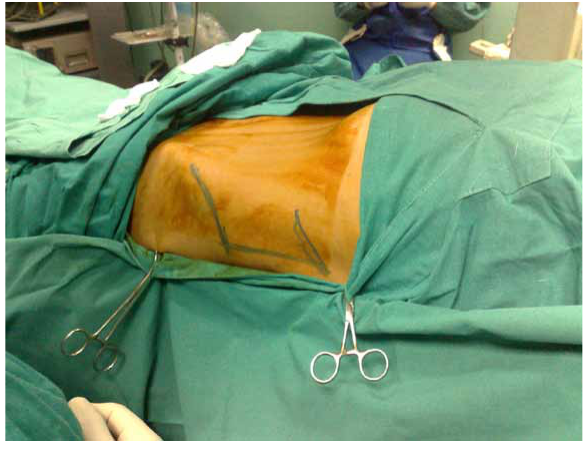
Figure 1 – surface marking of the lower rib, iliac crest and posterior axillary